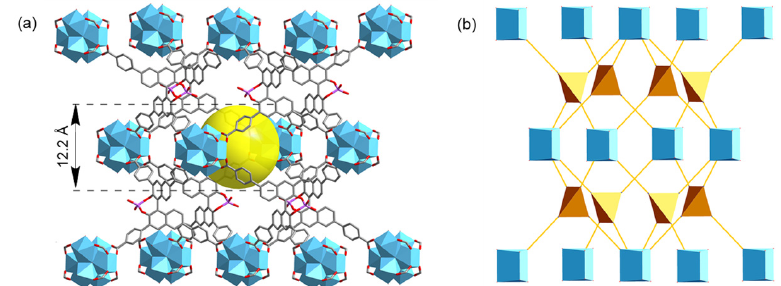
Figure 2. ( a ) PXRD patterns of Zr-MOF-P under different conditions. ( b ) TGA profile of Zr-MOF-P .